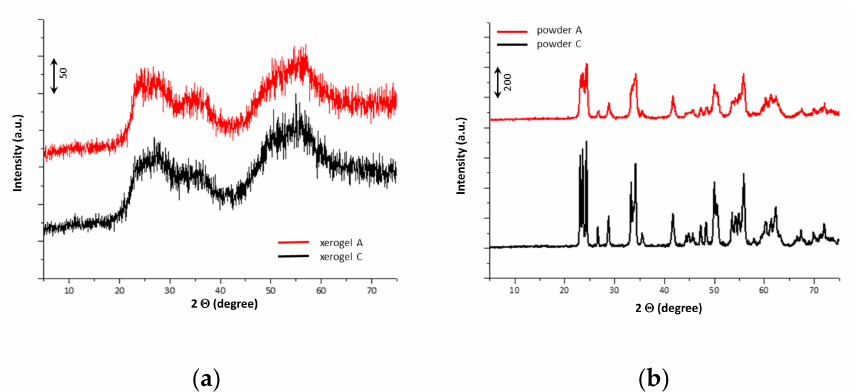
Figure 3. XRD patterns of the WO 3 xerogel ( a ) and corresponding powders obtained after annealing of the xerogels for 1 h at 450 ◦ C ( b ). Xerogel A and powder A denotes WO 3 prepared with 2-propoxy ethanol and 2-propanol. Xerogel C and powder C denotes WO 3 prepared with